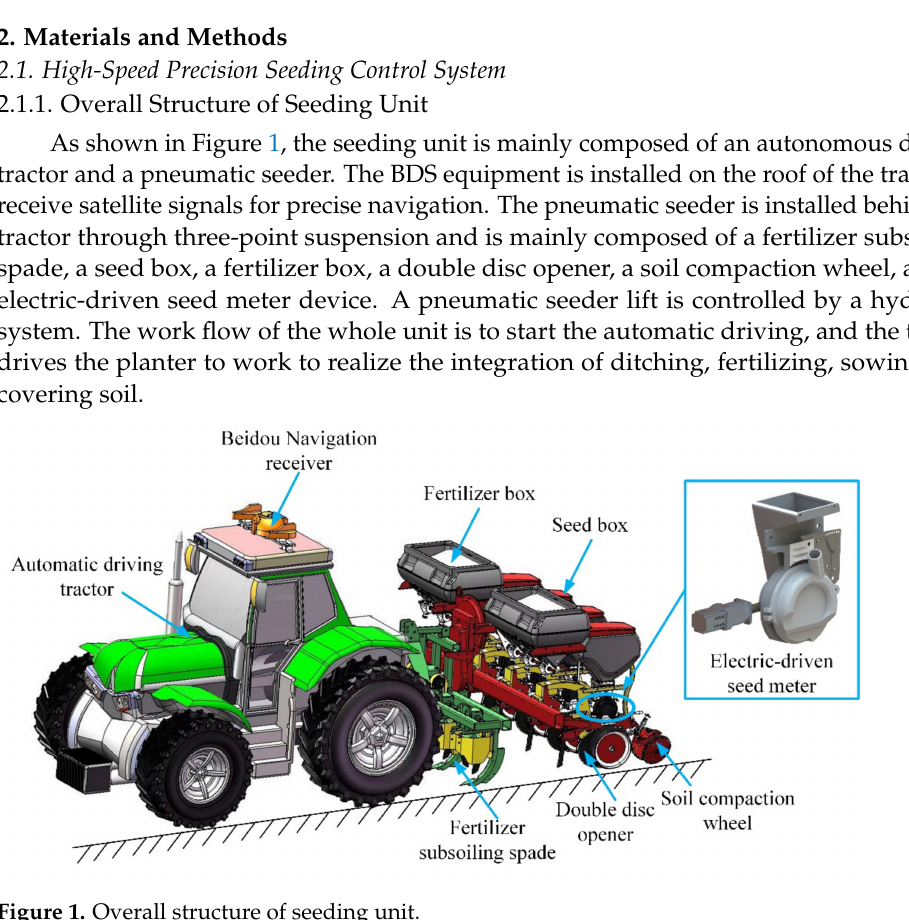
Figure 1. Overall structure of seeding